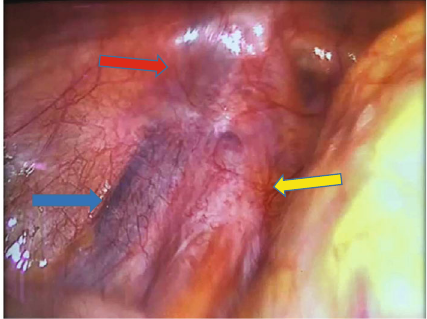
Figure 4: Laparoscopic view of the spermatic vessels (blue arrow) and vas deferens (yellow arrow) exiting the left “ closed ” deep inguinal ring (red